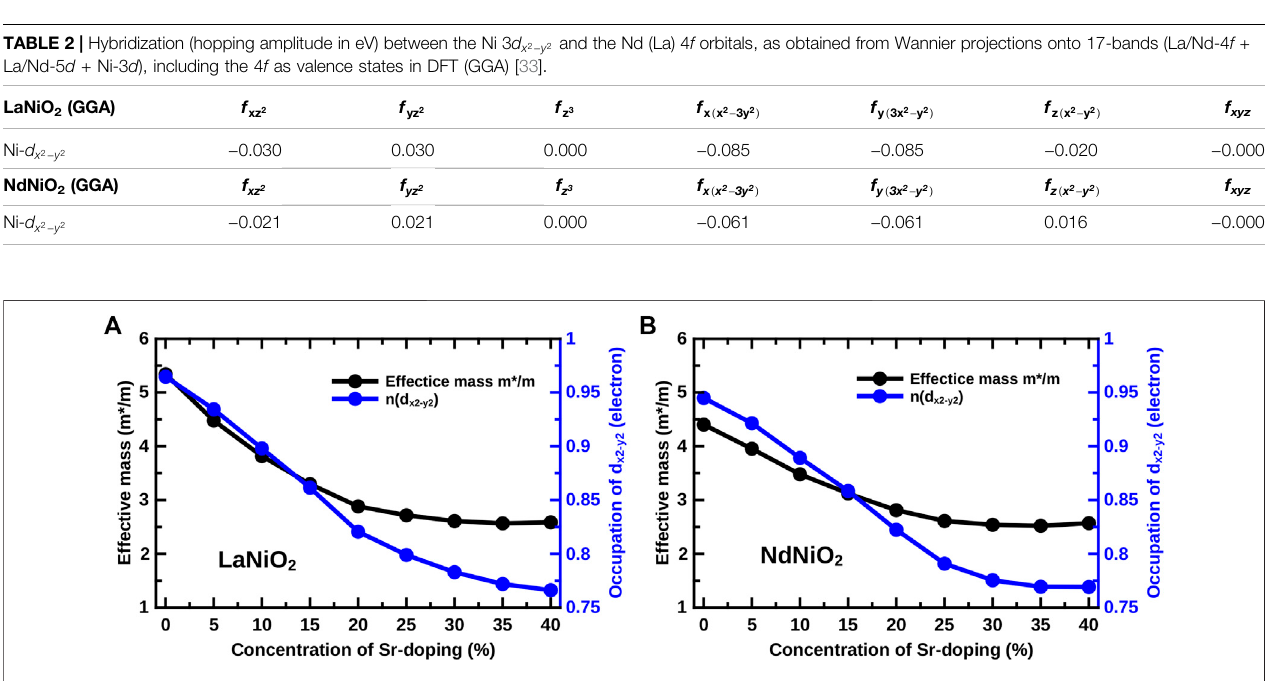
Frontiers in Physics |